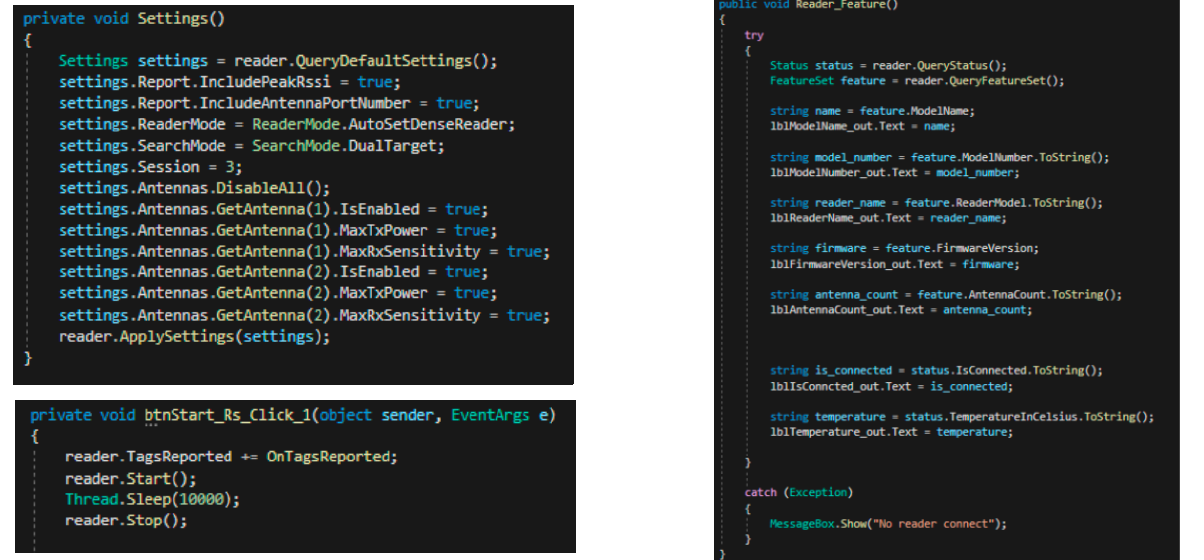
Figure 8. User interface: ( a ) database interrogation; ( b ) reared connection and monitoring status.